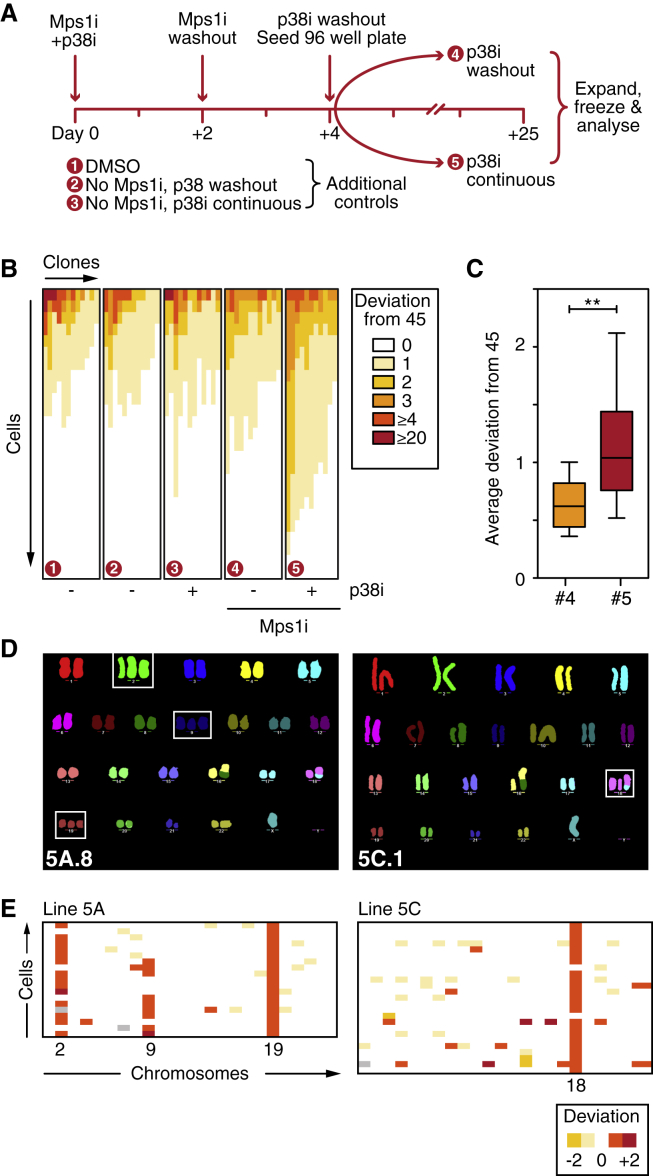
Pharmacological Inhibition of p38 Facilitates Expansion of Aneuploid Clones(A) Experimental design generating clones in the presence or absence of the p38 inhibitor SB203580 following exposure to AZ3146.(B) Chromosome counts showing the deviation from the modal number of 45, analyzing 25 spreads from at least 10 independent clones for each condition.(C) Box and whisker plot showing the average deviation from 45 for clones exposed to AZ3146 ± SB203580. ∗∗p < 0.01.(D) Representative M-FISH karyotypes from clones 5A and 5C, both generated in the continuous presence of SB203580. Boxes highlight whole-chromosome aneuploidies.(E) Quantitation of M-FISH karyotypes showing recurrent trisomies for chromosome 2, 9, and 19 (clone 5A) and chromosome 18 (clone 5C).See also Figure S7.